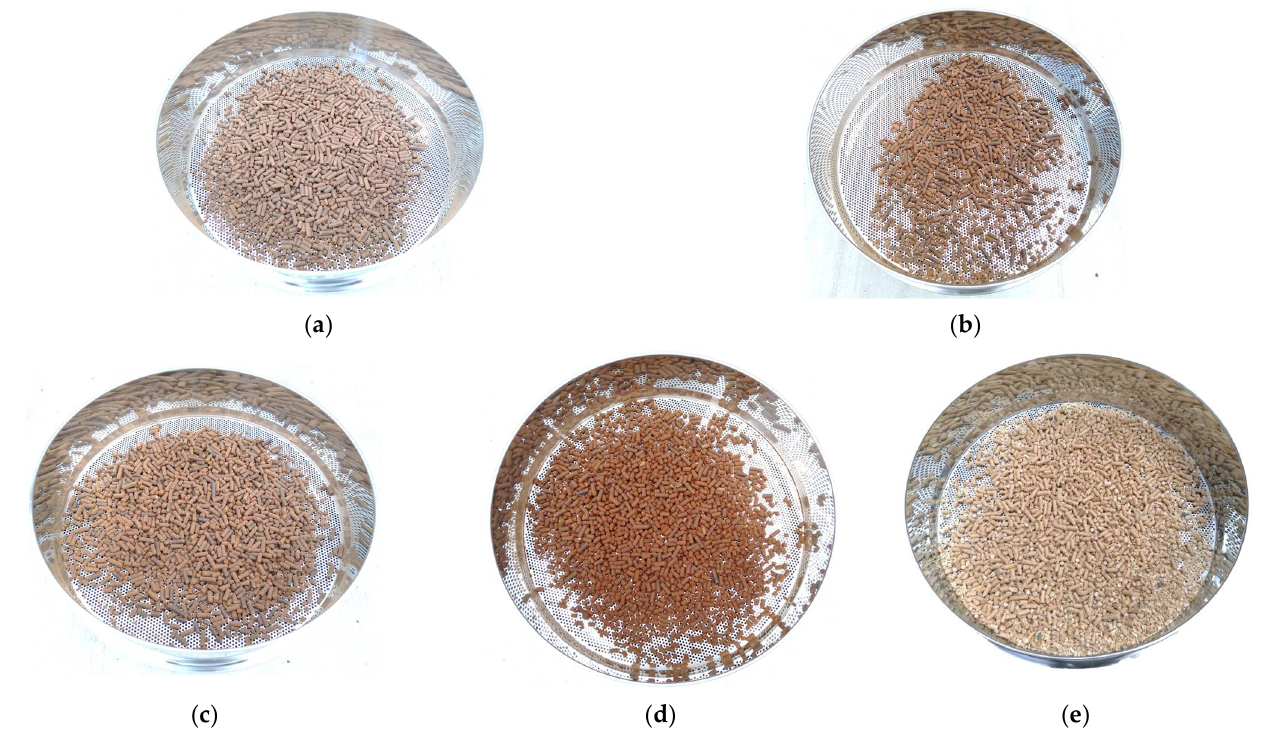
Figure 9. Scenario 1: poplar wood lignin pellets produced with an original feedstock having a moisture content of: ( a ) 8.01 wt%, ( b ) 26.21 wt%, ( c ) 30.07 wt%, ( d ) 38.83 wt% and softwood bark pellets ( e ) 6.57 wt%.